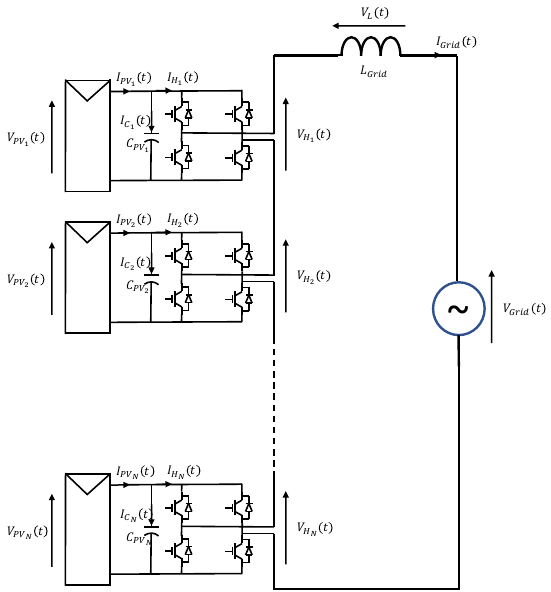
Figure 5. Cascaded H-Bridge Multilevel Inverter (CHBMLI) configuration.